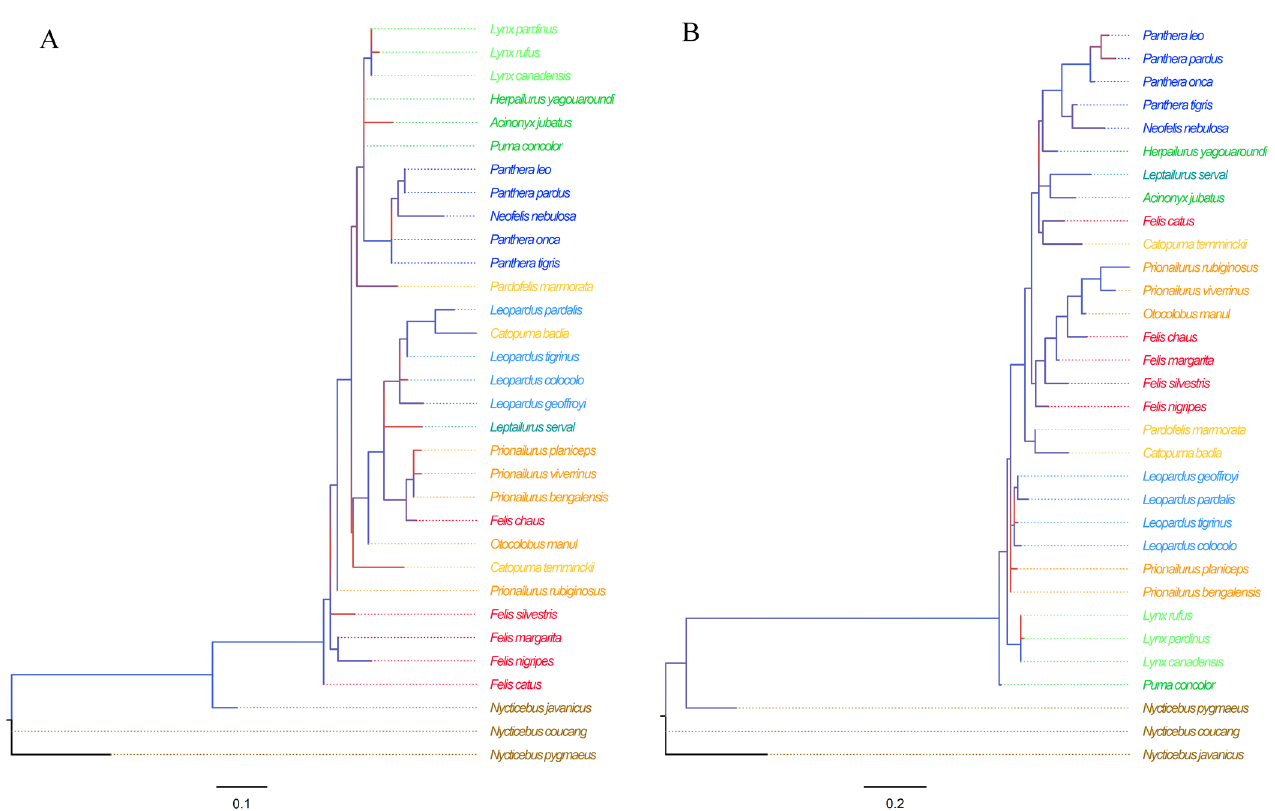
Figure 3. Phylogenetic analyses of felid Fel d 1 and loris BGE protein. (A) Chain 1, (B) chain 2. Felid species are colored according to their current grouping [41]. Branch support is shown as aLRT